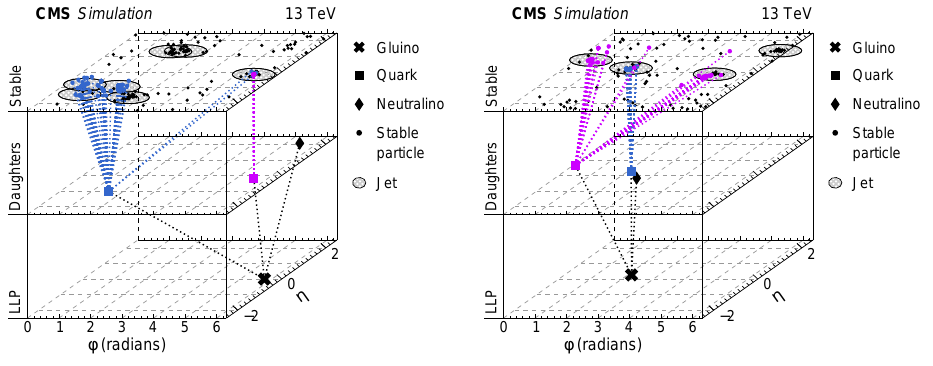
Figure 1. Two example decays of a gluino into a quark / antiquark pair and a neutralino. The positions in η and φ of the gluino, the quarks and neutralino, and the jets clustered from the stable particles after hadronisation are shown in the lower, middle, and top layer, respectively. The figures are taken from Ref.